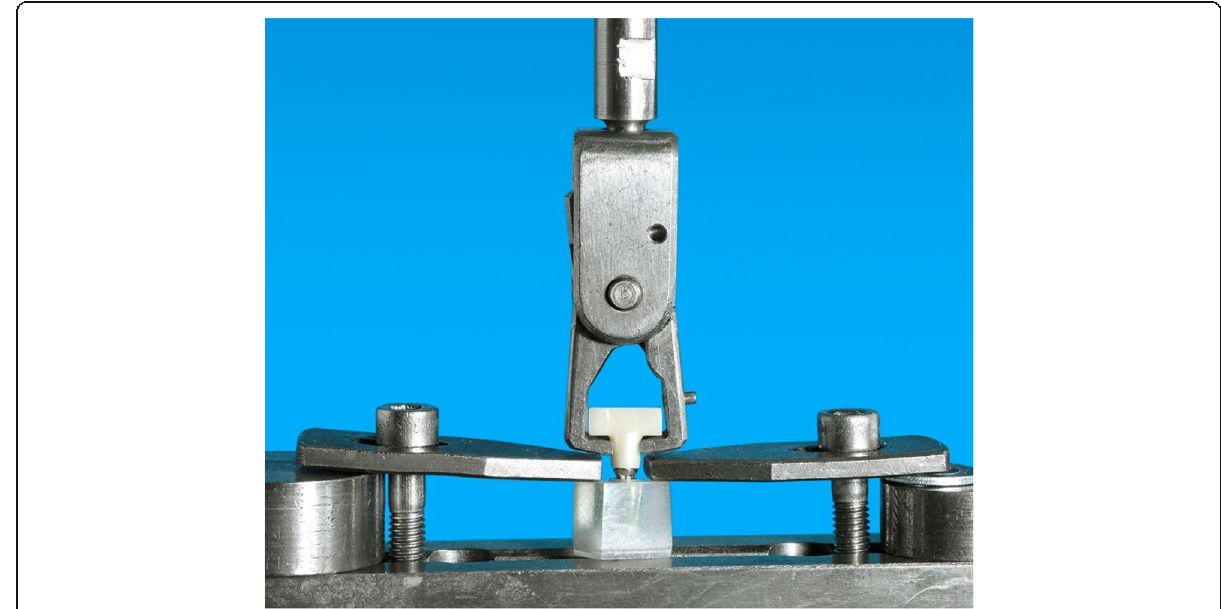
Fig. 4 Clamped test specimen with retaining clips positioned under the retaining wings